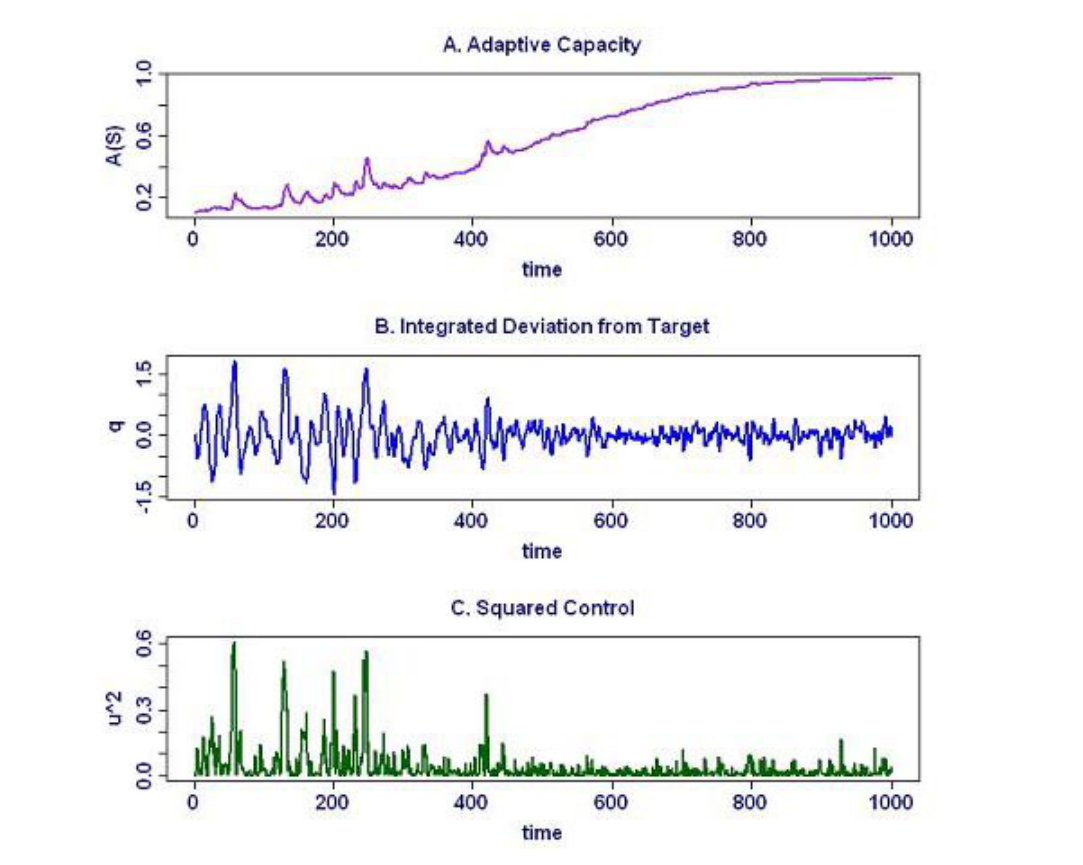
Fig. 6. Emerging from a poverty trap: time series as S* is raised gradually from 1 to 5 over 1000 time steps. (A) Adaptive capacity A(S[t]). (B) Integrated deviation from target, q[t]. (C) Squared control, u[t]